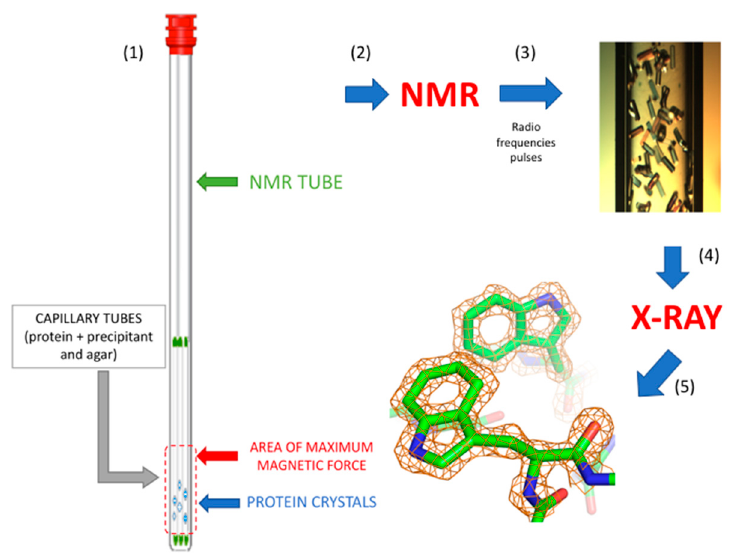
Figure 5. Experimental setup for the crystal growth in gels under the influence of magnetic field of 16.5 Tesla applying radio frequency pulses. The numbers represent the sequence of experiments ( 1 – 4 ) until obtaining the 3D structure ( 5 ). The capillary tube between ( 3 ) and ( 4 ) is 1 mm in diameter. The 3D structure shown after ( 5 ) is the electron density maps (2Fo-Fc) of the best crystals at a contour level of 1 σ . This selected area comprises tryptophan residues (Trp 28 and 108) showing the crystal quality.